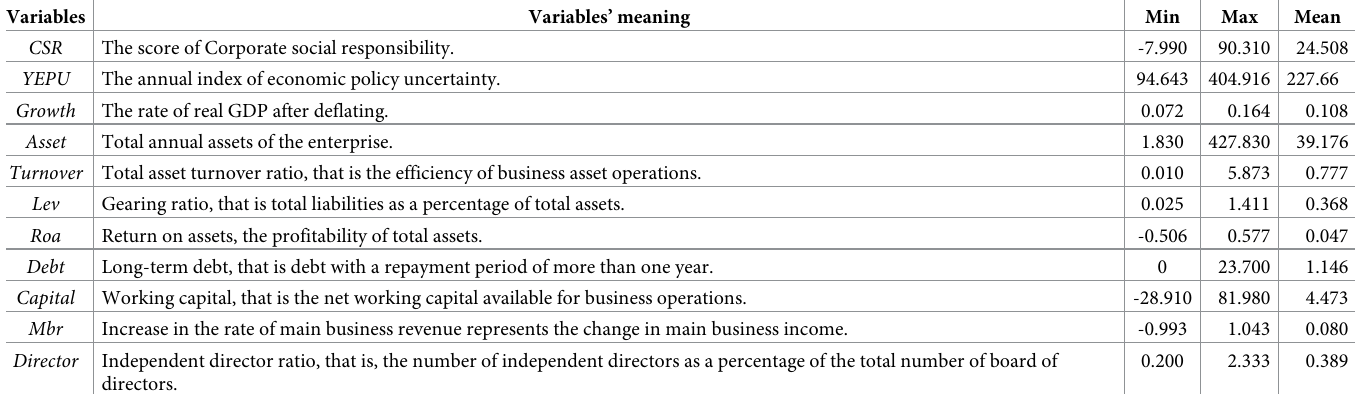
Table 1. Descriptive statistics of